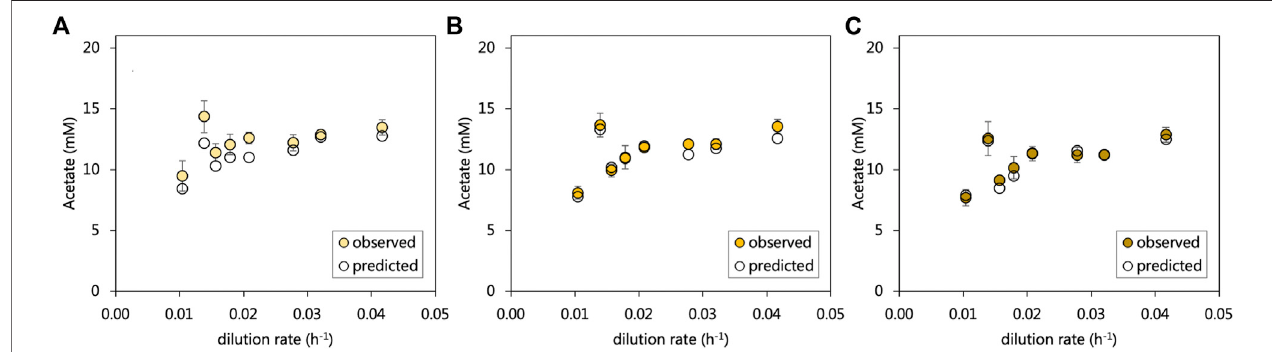
FIGURE4| Theobservedandpredictedacetateconcentrationsleavingthe (A) inlet (B) middleand (C) ef fl uentzoneoftheacetate-supplementedUAPBR.Acetate concentrations were predicted with the assumptions that (i) all sulfate reduction observed was linked to the oxidation of acetate according to Eq. 1, and (ii) that the